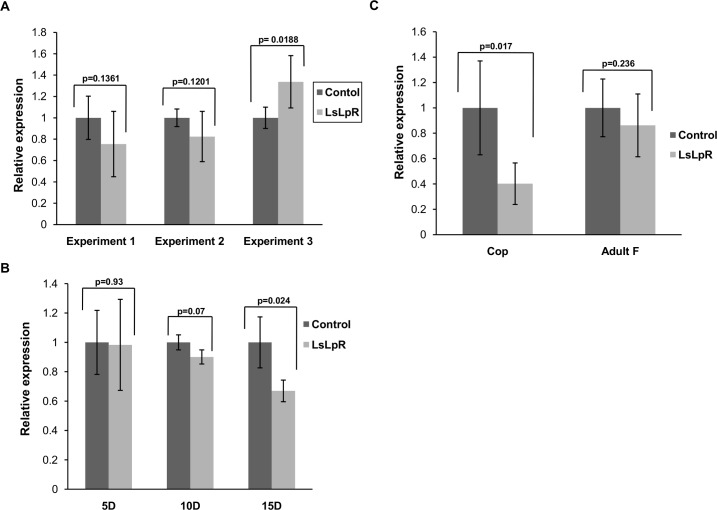
Treatment with dsRNA against LsLpR.(A) Relative expression of LsLpR in the adult females after injection of dsRNA in pre-adult females (30–32 days post injection). (B) Relative expression of LsLpR after injection of dsRNA (fragment 1 + 3) in adult females and measured at days 5, 10 and 15 (post injection). Expression PCR was carried out on 5 female lice from control and knock-down group at each time point. (C) Relative expression of LsLpR in copepodids (n = 5 × 20) after knock down (fragments 1 + 3) in nauplii I, assayed before the infection of a host and in adult female lice at the time of termination of the experiment. Error bars show standard deviation and P-values for independent-samples T-test analysis are shown, expression levels of LsLpR in control versus LsLpR dsRNA-treated group.